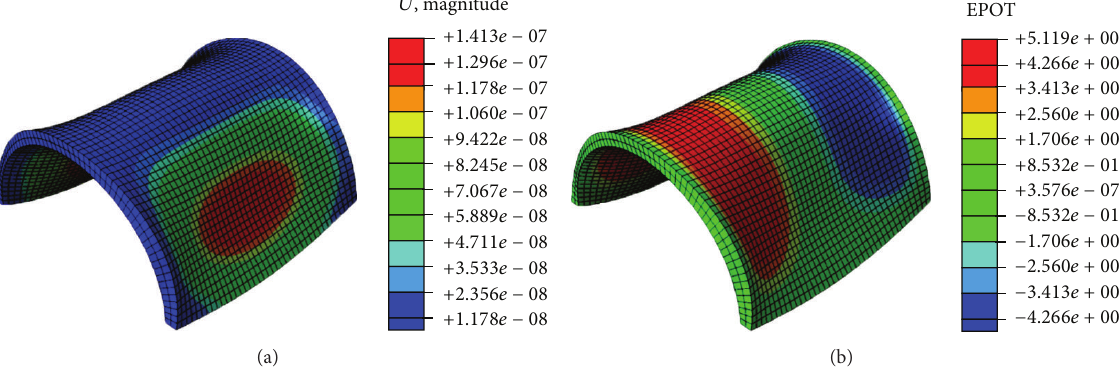
Figure 4: The dynamic response of the panel at 450 Hz due to (a) mechanical excitation; (b) electrical